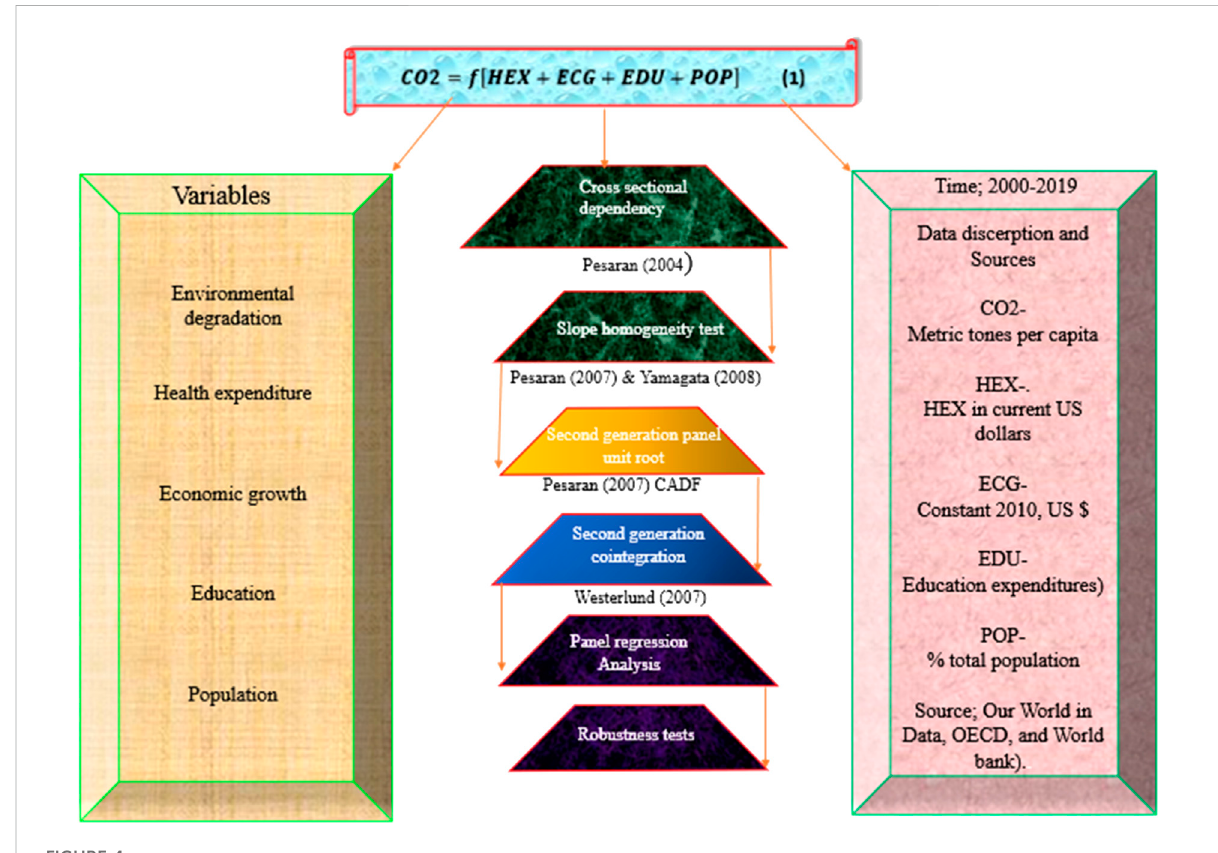
FIGURE 4 Methodological framework. Source, Authors own